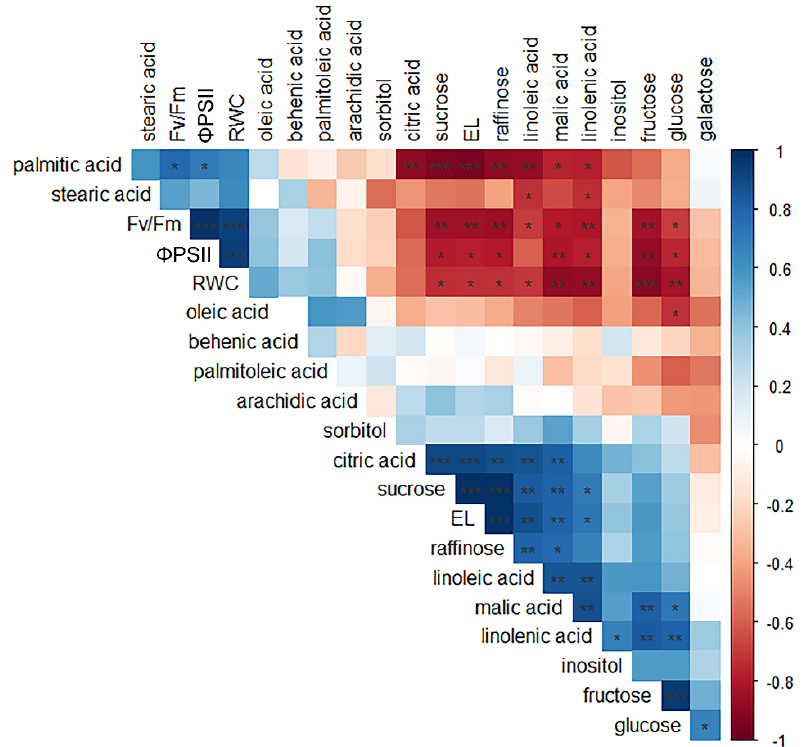
Figure 10. Correlation matrix for leaf relative water content (RWC), electrolyte leakage (EL), photo- chemical parameters ( Φ PSII and Fv/Fm), and biochemical variables (sugar and fatty acids content) measured at midday in leaves of Haberlea rhodopensis when exposed from control to low temperatures. The color scale ranges from red to blue according to the maximum ( −1 ) and minimum (+1) Pearson’s correlation coefficient, respectively. Significance correlations are indicated as: * p ≤ 0.05; ** p ≤ 0.01; *** p ≤ 0.001.